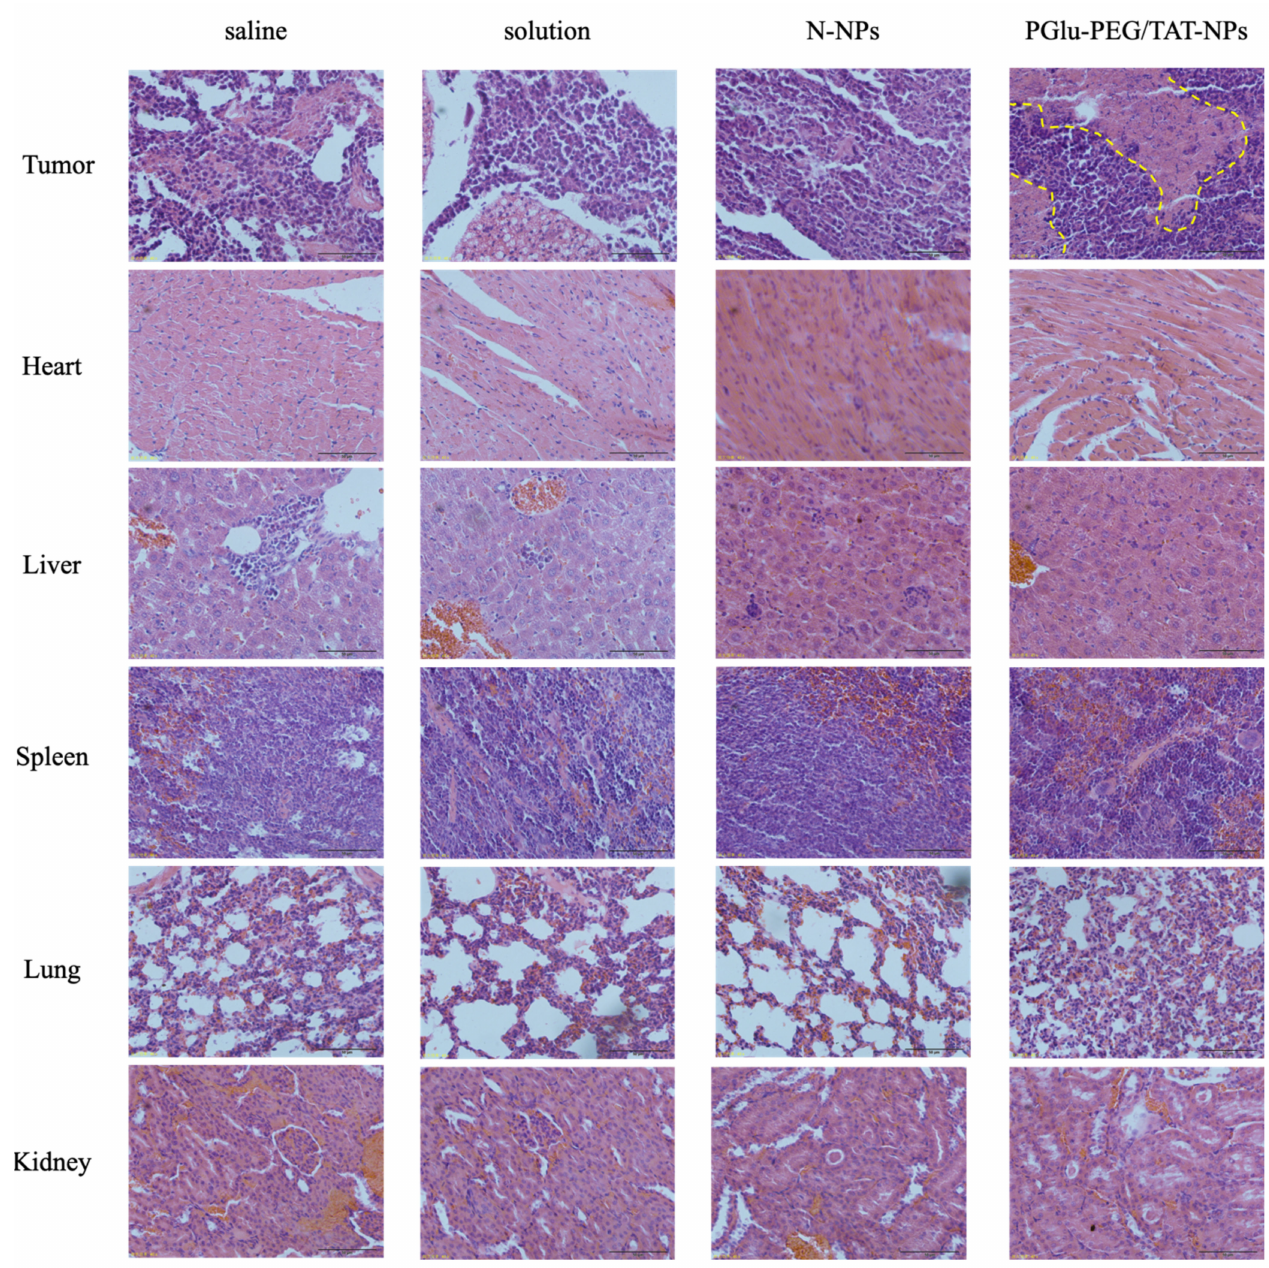
Figure 8. Light microscopy images of H&E staining tumor and major organs after the treatment of saline, solution, N-NPs, and PGlu-PEG/TAT-NPs. Scale bar represents 50 µ m. Solution: DSF dissolved in saline with a low content of Cremophor EL/ethanol. N-NPs: DSF-loaded naked nanoparticles. PGlu-PEG/TAT-NPs: shell/core composite nanoparticles. Yellow dotted lines: necrotic and apoptotic cells